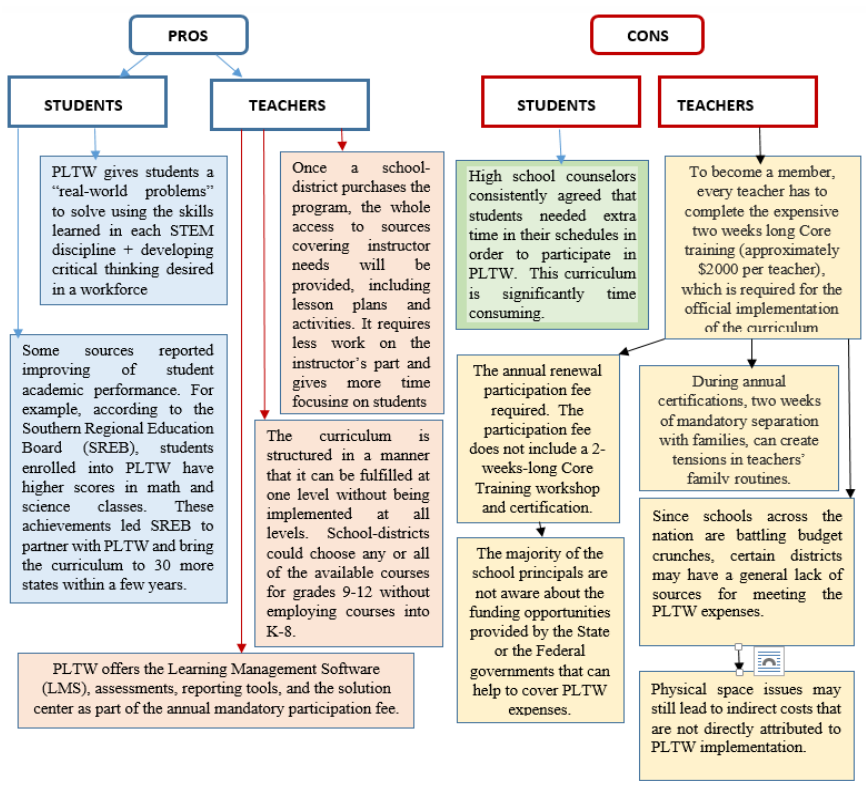
Fig. 1. Pros and Cons of the «Project Lead the Way» Educational